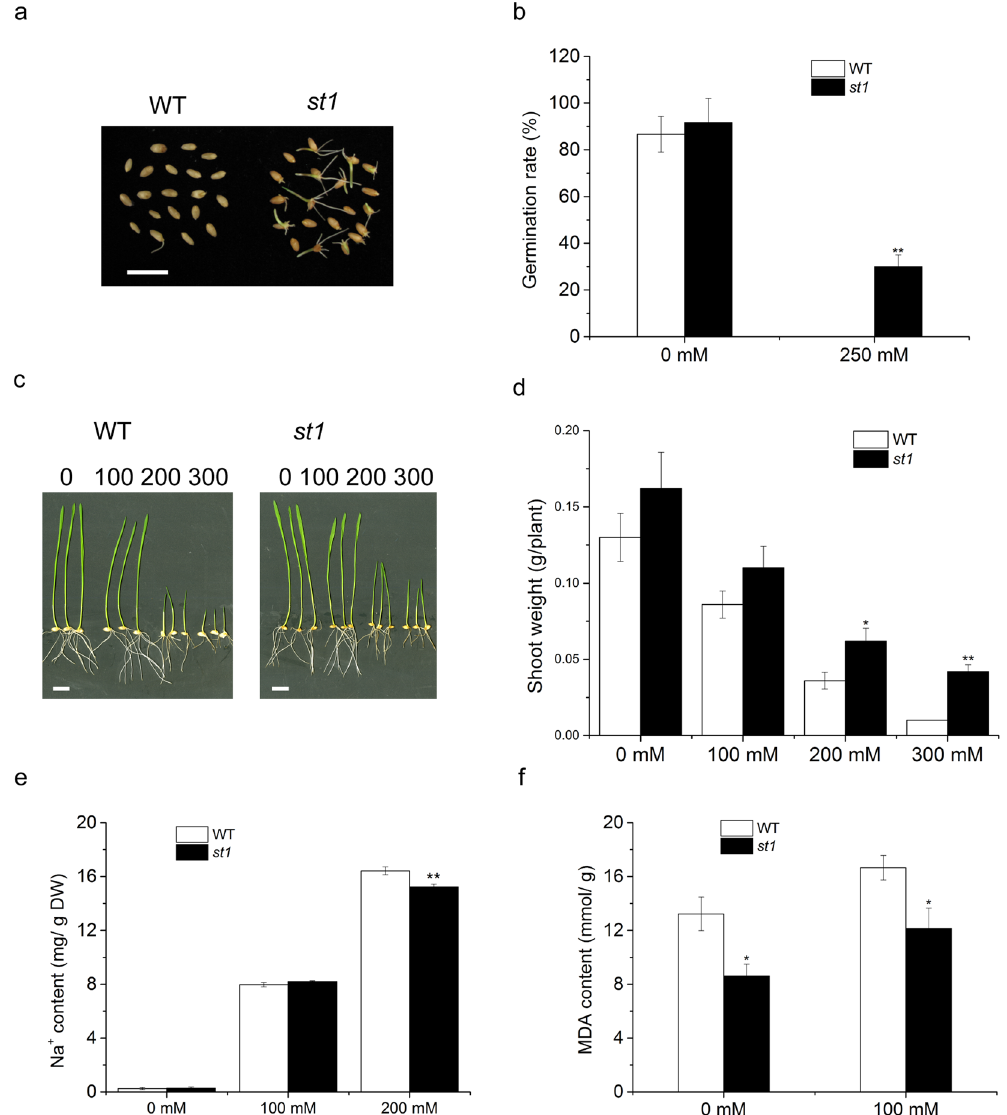
Figure 1. Phenotypical comparisons of WT and mutant in response to salt treatment. ( a ) The phenotypes and ( b ) germination rate of WT and st1 seeds exposed to 250 mM NaCl. ( c ) The phenotypes and ( d ) shoot weights of WT and st1 plants grown in 0, 100, 200, or 300 mM NaCl after germination. Bars = 2 cm. ( e ) The Na + concentration in the shoots of WT and st1 plants treated with 100 or 200 mM NaCl or without treatment. ( f ) The MDA content in the shoots of WT and st1 plants treated with 100 mM NaCl. Values are means ± SD. Student’s t-tests were used to assess the significance of differences from WT plants, * P < 0.05, ** P <